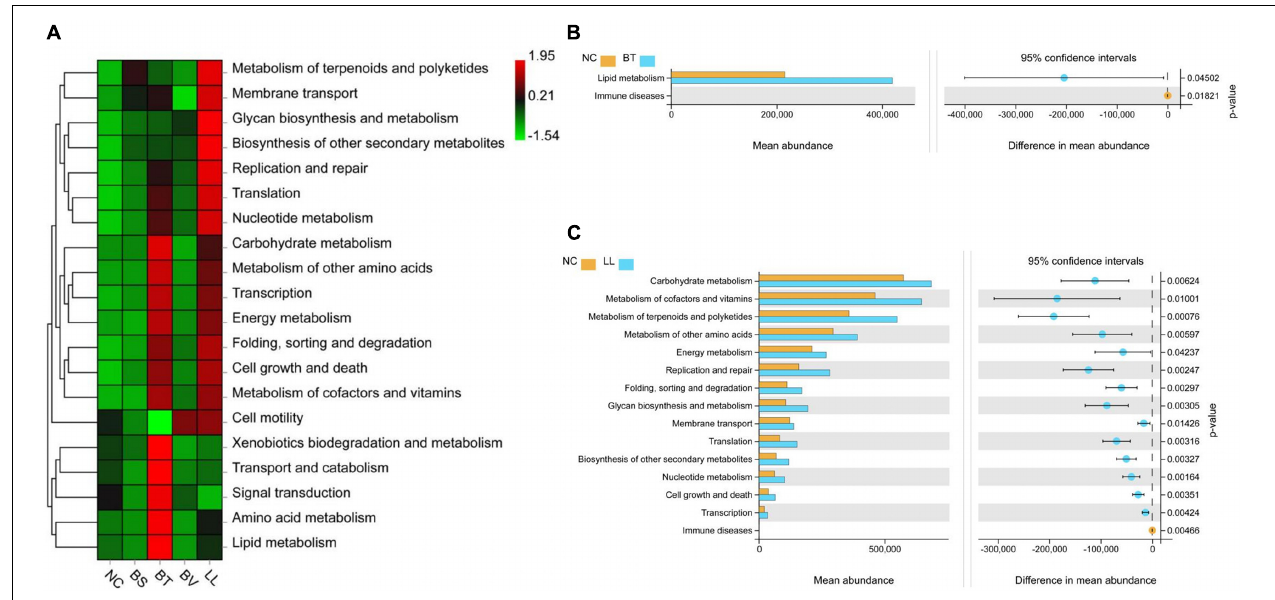
FIGURE 8 | Predicted functional profiles of jejunal microbiota using PICRUSt2 at level 2. (A) The heat map analysis among all groups. (B,C) Analysis of function difference between NC group and BT (or LL) group. Differences were calculated by Welch’s t -test ( p < 0.05). NC, control diet; BS, control diet containing 1 × 10 7 CFU/g of Bacillus siamensis ; BT, control diet containing 1 × 10 7 CFU/g of Bacillus tequilensis ; BV, control diet containing 1 × 10 7 CFU/g of Bacillus velezensis ; and LL, control diet containing 1 × 10 7 CFU/g of Lactococcus lactis